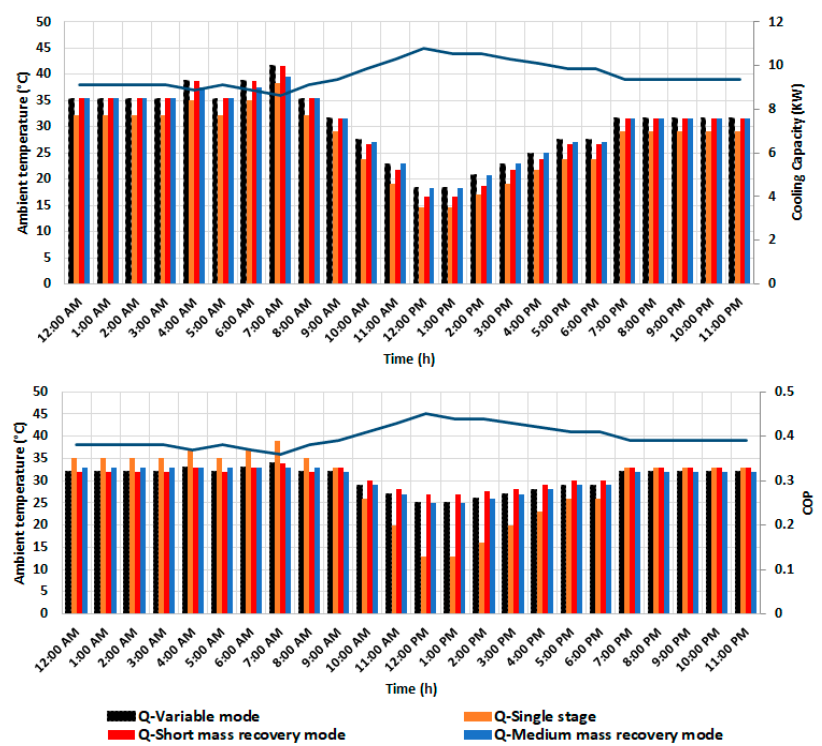
Figure 21. Measured ambient temperature and expected cooling capacity and COP for various modes (day 1).